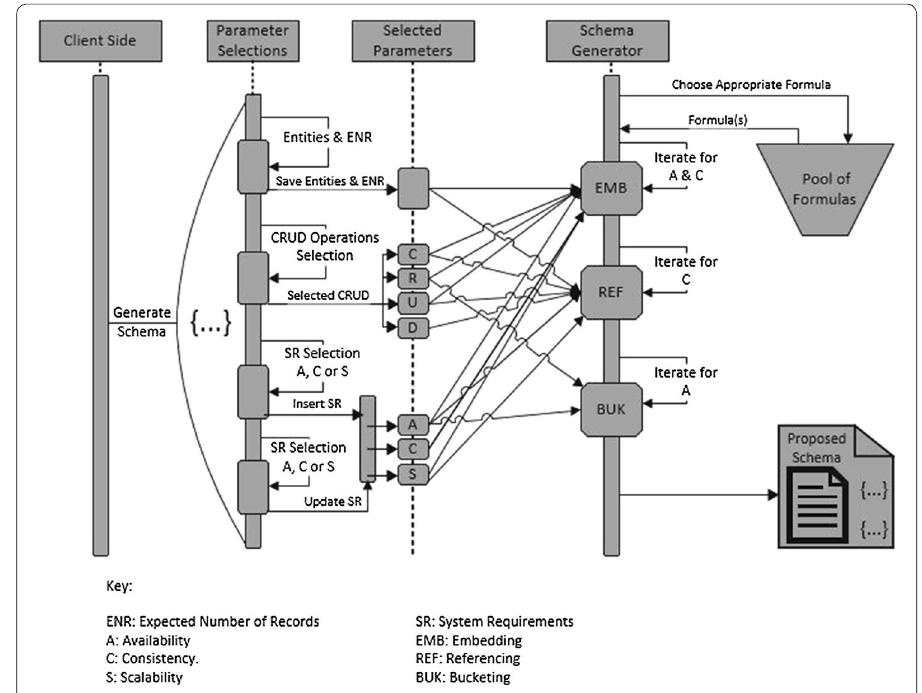
Figure 2 represent the architecture of the proposed model. There are four phases or lay- ers in the architecture which are represented by rectangle shapes. Document schemas are depicted with curly brackets symbols, while the flow directions are indicated using arrowed-lines. Other symbols are labeled as shown in the